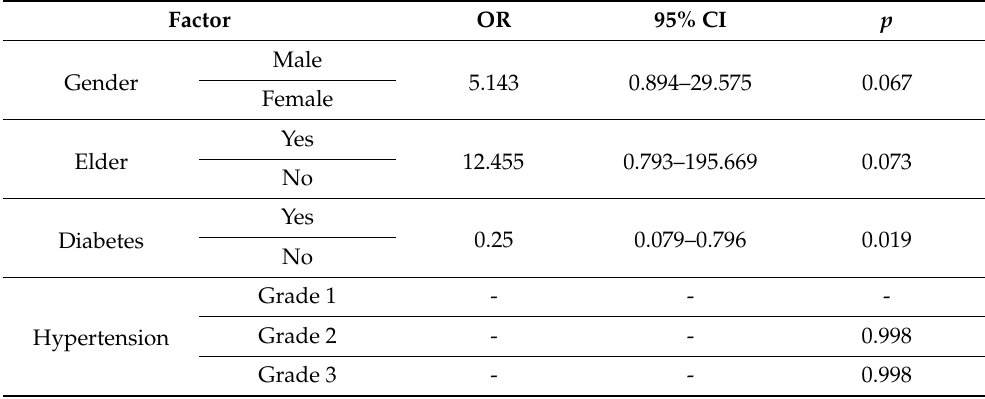
Table 3. Multivariable logistic regression analysis between plasma total homocysteine and some related factors.